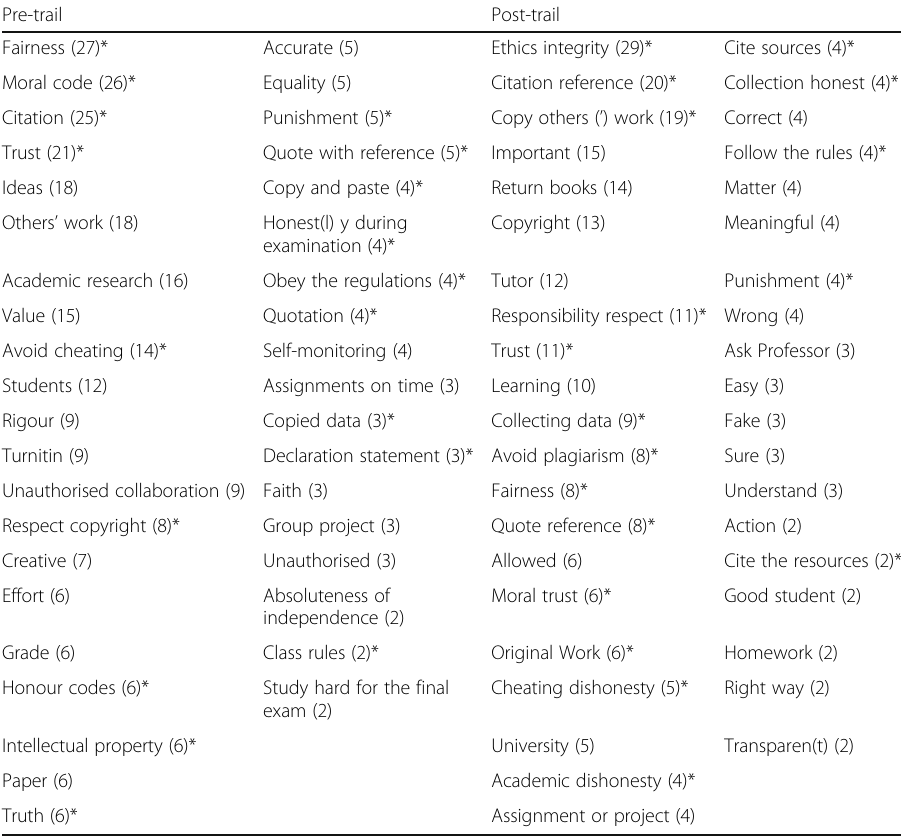
Table 6 Year 3 business ethics students ’ pre-/post-trail terms/phrases clusters from